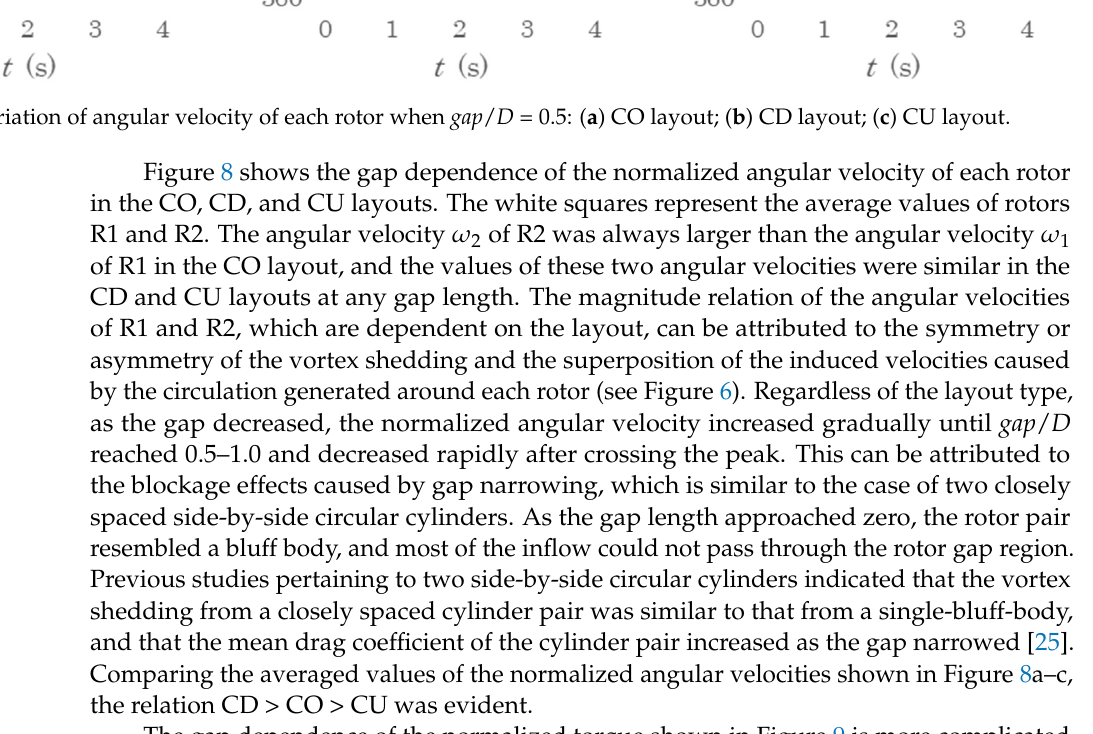
Figure 8. Gap dependence of normalized angular velocity of each rotor: ( a ) CO layout; ( b ) CD layout; ( c ) CU layout. The gap dependence of the normalized torque shown in Figure 9 is more complicated than that of the angular velocity. In the CO layout, the mean torque Q 2 of R2 was greater than the mean torque Q 1 of R1 at all gap lengths. Moreover, the difference in the mean torques of the two rotors increased as the gap length decreased. However, Q 2 was not always greater than Q 1 when gap / D was varied in the CD and CU layouts. This was likely